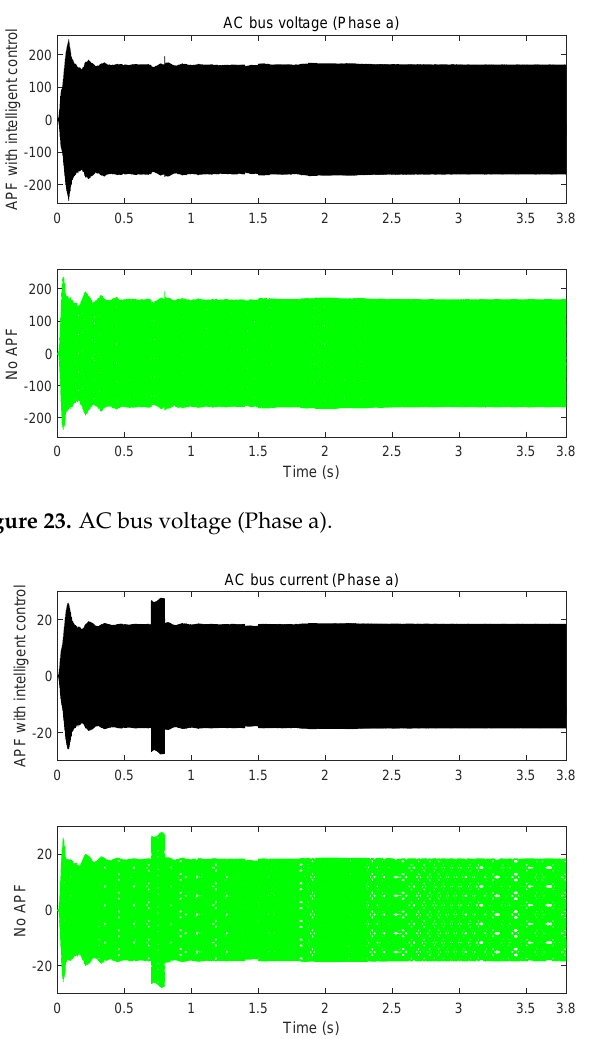
Figure 22. DC voltage and current comparison between no APF and has APF in MEA power system.